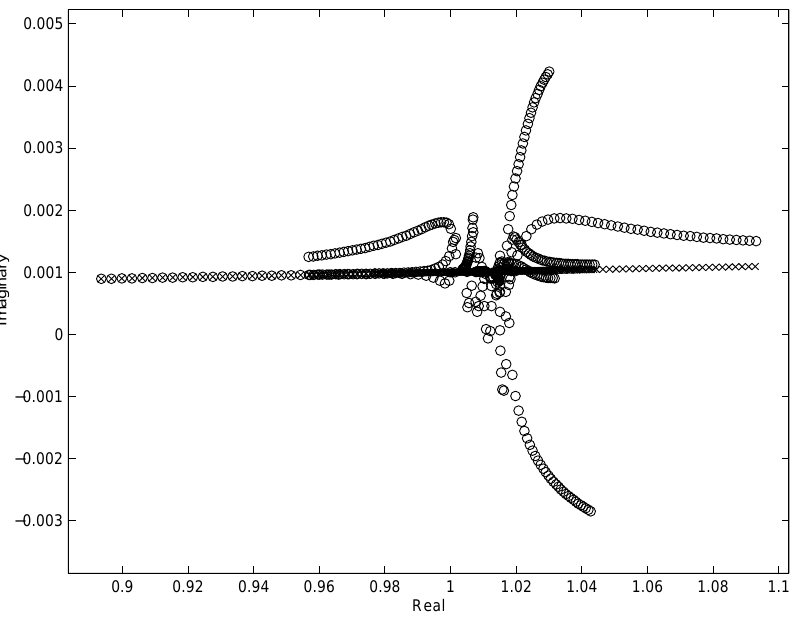
Fig. 8. Blade 8 pole/zero locus as mistuning standard deviation is varied from 0 to 0.1 for the mistuning pattern given in Fig. 3(b). × poles, ◦